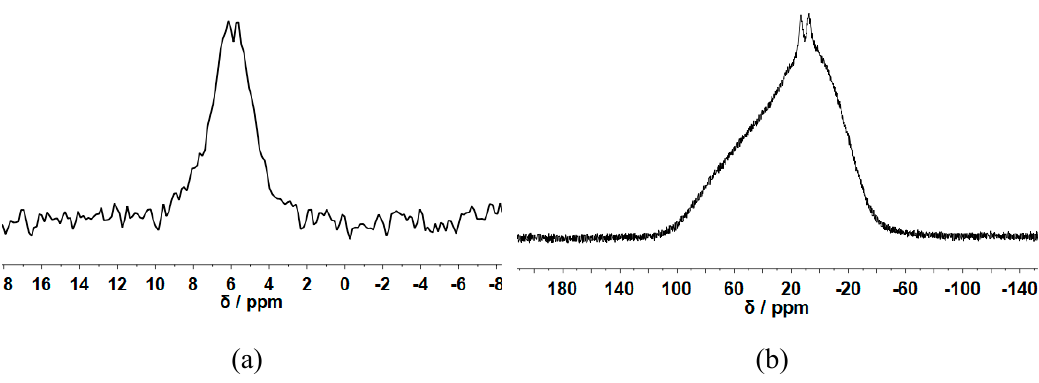
Figure 2. 6 Li ( a ) and 11 B ( b ) magic-angle spinning nuclear magnetic resonance (MAS NMR) spectra of TAB1.